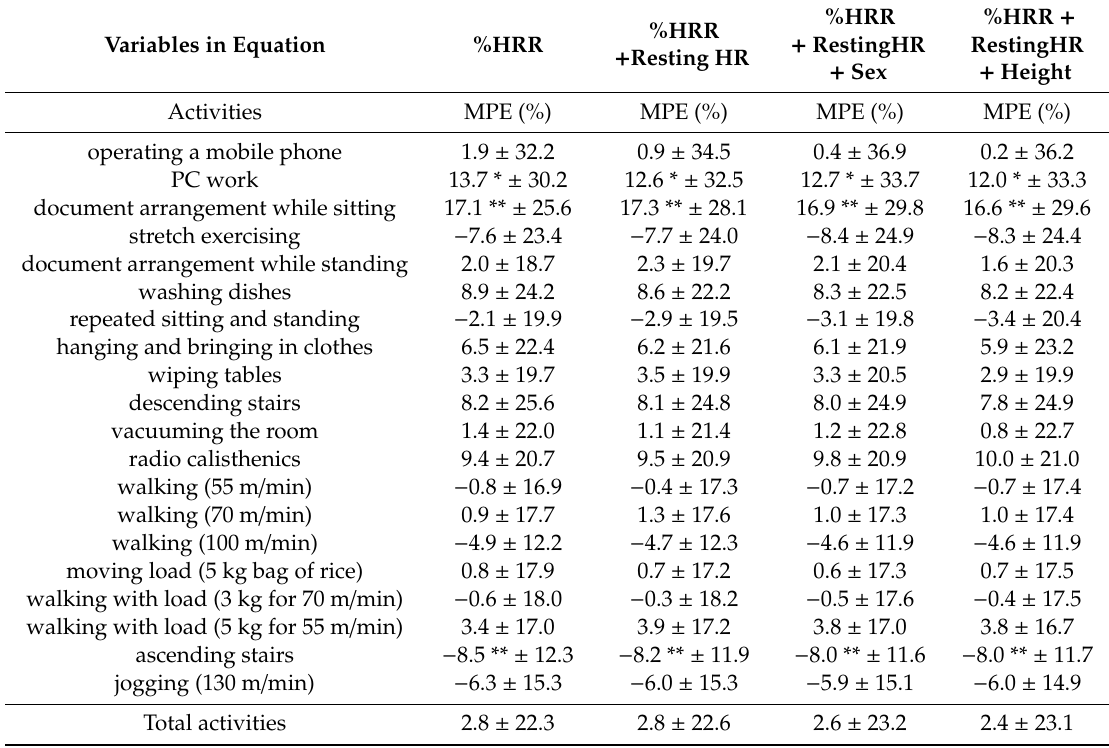
Table 6. Mean percent error of the predictive equations with leave-one-out method.